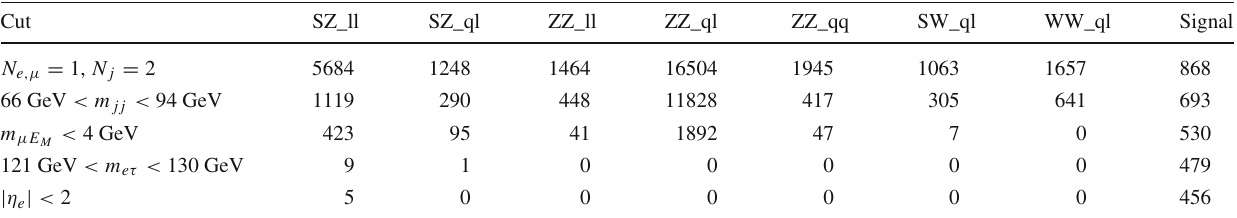
Fig. 1 The upper bounds at 95% CL on the three CLFV Higgs decay rates (left) and the corresponding CLFV couplings (right) given by the LHC [64,81] (red), compared to the corresponding bounds expected to be given by the CEPC, the FCC-ee (green) and the ILC (blue). See text for details Table 3 The numbers of background events in different categories and signal events surviving the cuts in the analysis of H → e ± τ ∓ at the CEPC. See text for